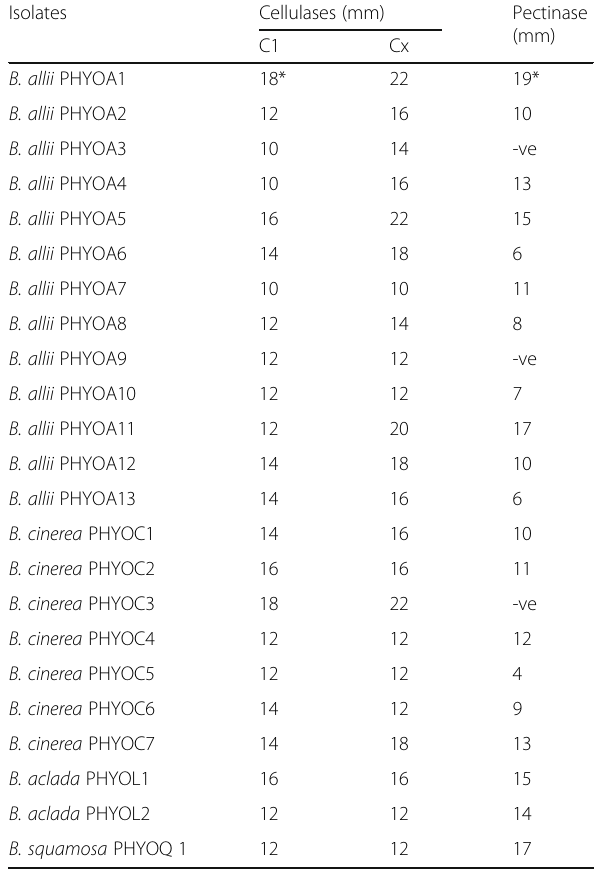
Table 3 Cellulases and pectinase production of Botrytis species of onion in vitro